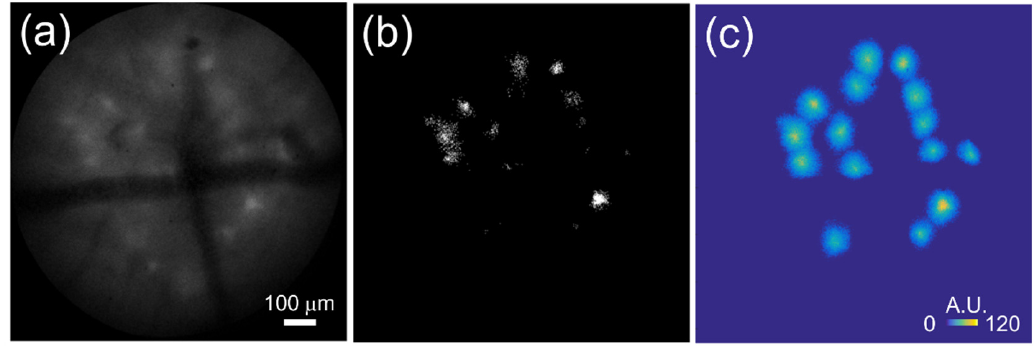
Figure 2. Gray distance compensation. ( a ) The raw fluorescence image collected by the fiber optic imaging device. ( b ) Binarization of the post gray transformation image in which white regions imply the active regions. ( c ) Plot of active regions extracted by distance compensation. A.U.: arbitrary unit.